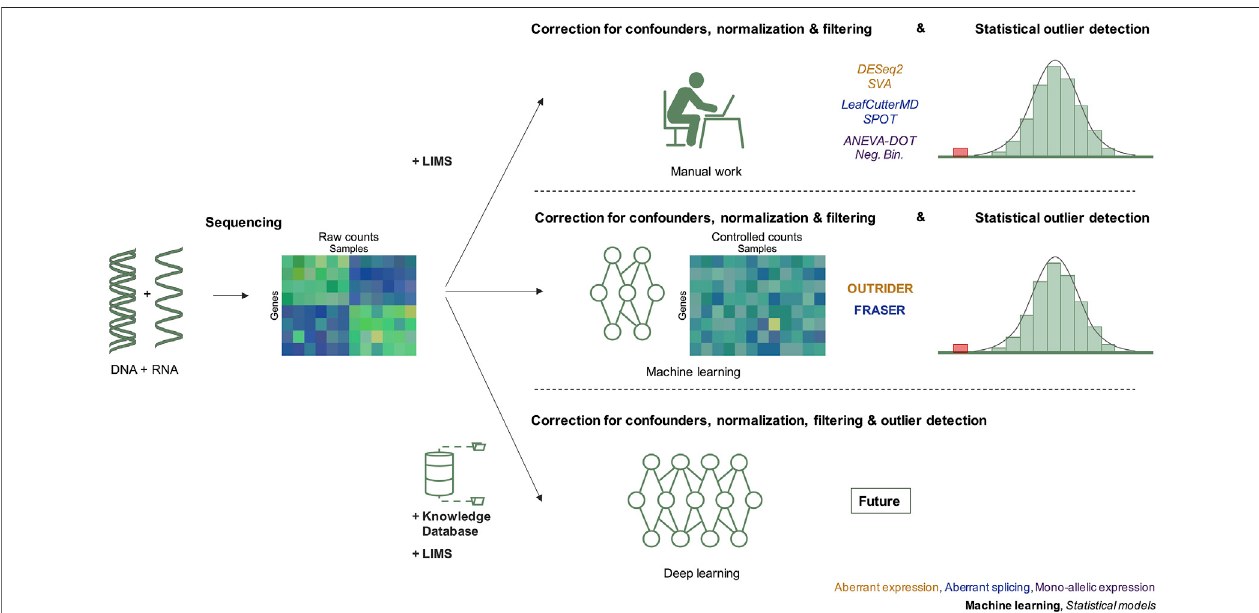
FIGURE1| EvolutionofRNAseqdatamodelinginthediagnosisofraregeneticdisorders.TheintegrationofRNAseqinmoleculardiagnosticsincludesthreesteps, data generation by DNA and RNA sequencing resulting in raw counts, correction for confounders, and detection of outliers after statistical modeling. Before 2018, the correction for confounders was based on manual work considering known technical and biological variables recorded in the LIMS. Since 2018, methods applying machinelearninghavebeenintroduced.Wepredictthatinthefuture,deeplearningapproacheswillintegrateknowledgedatabases,sequencingdataandcombine normalization, and statistical outlier detection. Next to each diagram, the different methods used to detect RNAseq outliers of the corresponding cases are given. LIMS, laboratory information management system.